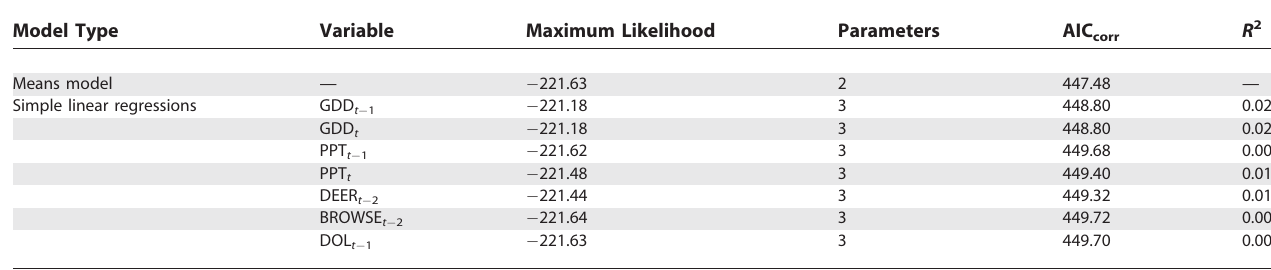
Table 3. Model Comparison Statistics for Independent Variables Potentially Influencing NIP Based on the Full Dataset (58 Plot Years) Model Type